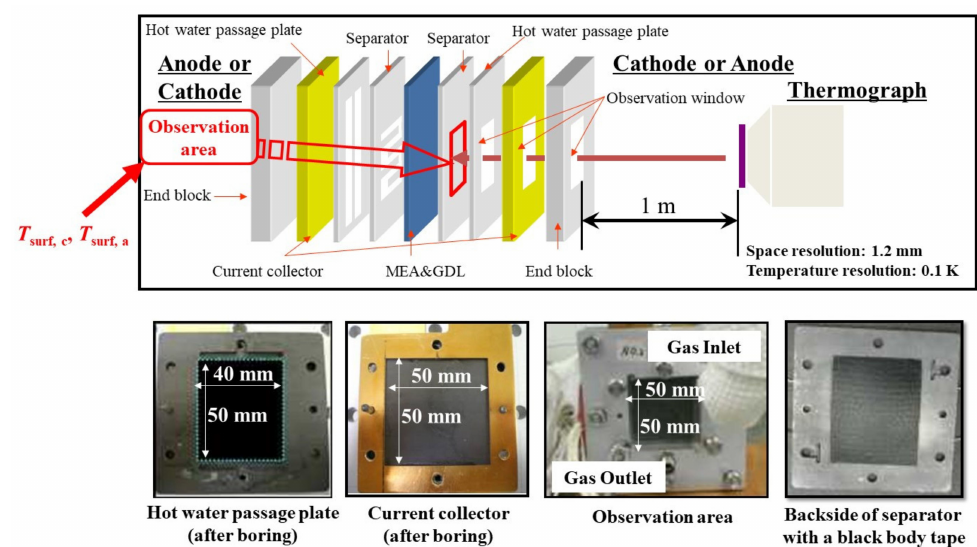
Figure 3. Structure of a single polymer electrolyte fuel cell, to measure the temperature distribution by a thermograph.